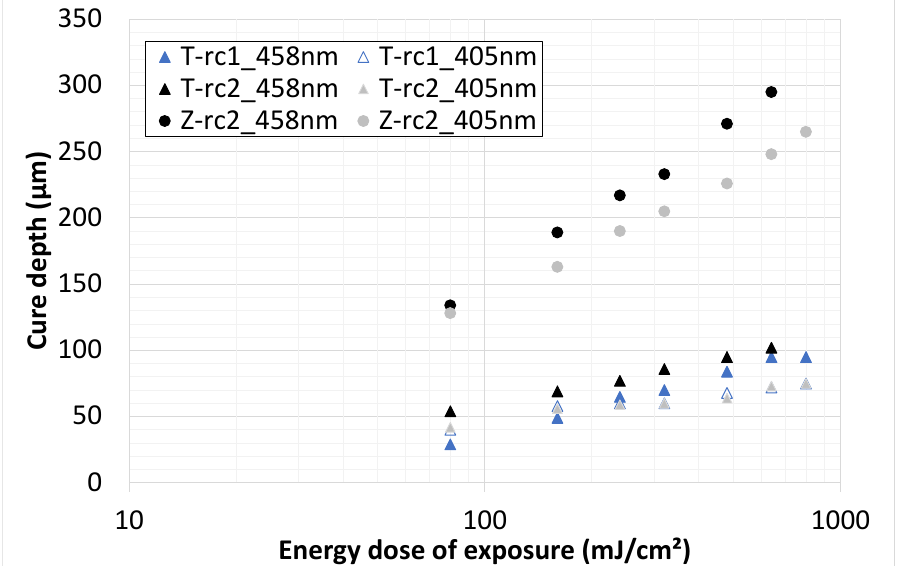
Figure 6. Cure depth vs (log) energy dose; titania (T) slurries based on rc1 and rc2; zirconia (Z) slurry based on rc2; particle content of 46 vol.%; 405 and 458 nm wavelength.